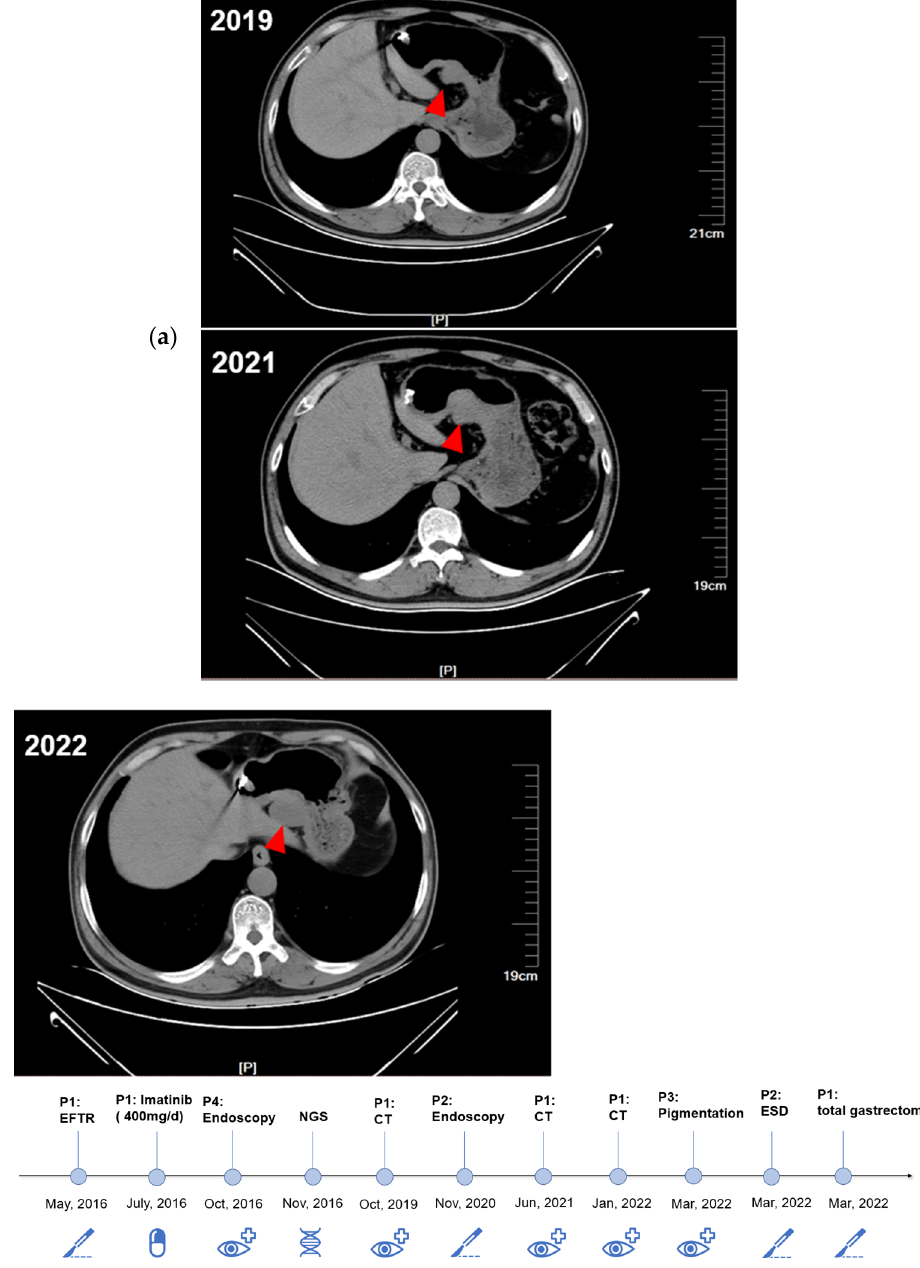
Figure 2. The diagnostic and therapeutic process of this family. ( a ) CT showed continued progres- sion of the proband’s GISTs (red arrows). ( b ) The overall timeline of the entire follow-up